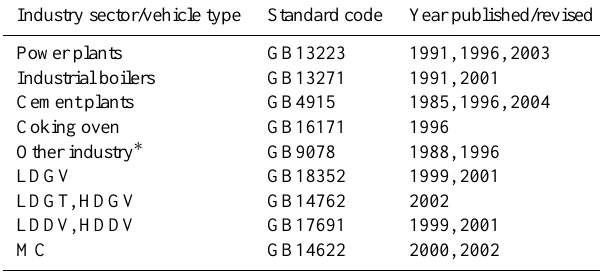
Table 4. Emission standards for industry and on-road vehicles be- fore 2005.